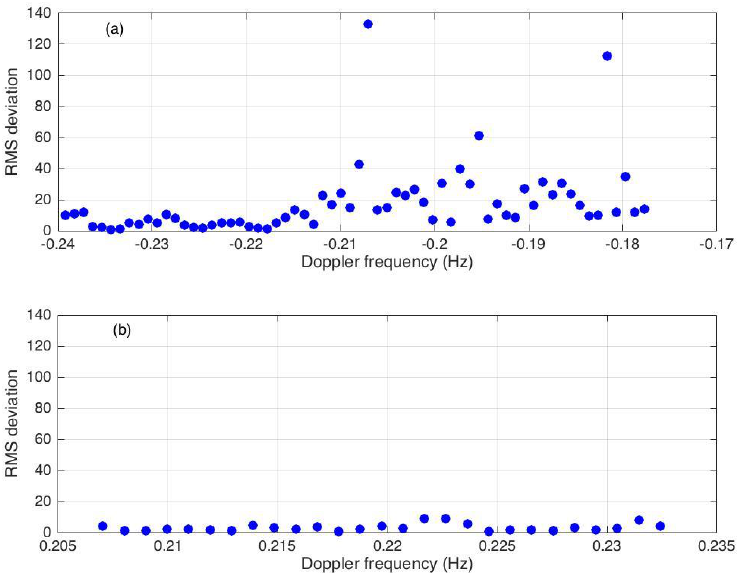
Figure 4. RMS deviations plotted vs. Doppler frequency for Shelter Cove on 7 March, 2018, 00:30 range 18 km ( a ) negative ( b ) positive Doppler a.m., range 18 km ( a ) negative ( b ) positive Doppler frequencies.